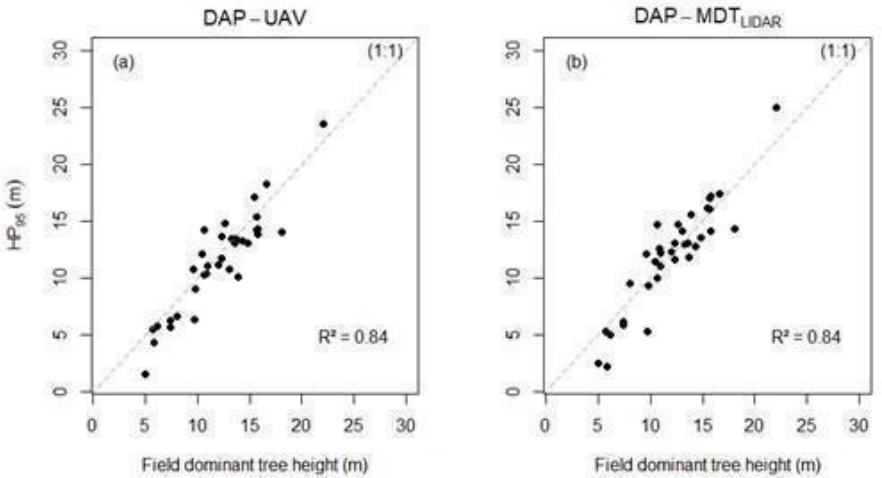
Figure 9. Dispersion plots between the HP 95 metric (95th percentile) obtained by ( a ) DAP and ( b ) DAP-DTM LiDAR compared with the dominant heights of the TFI plots.